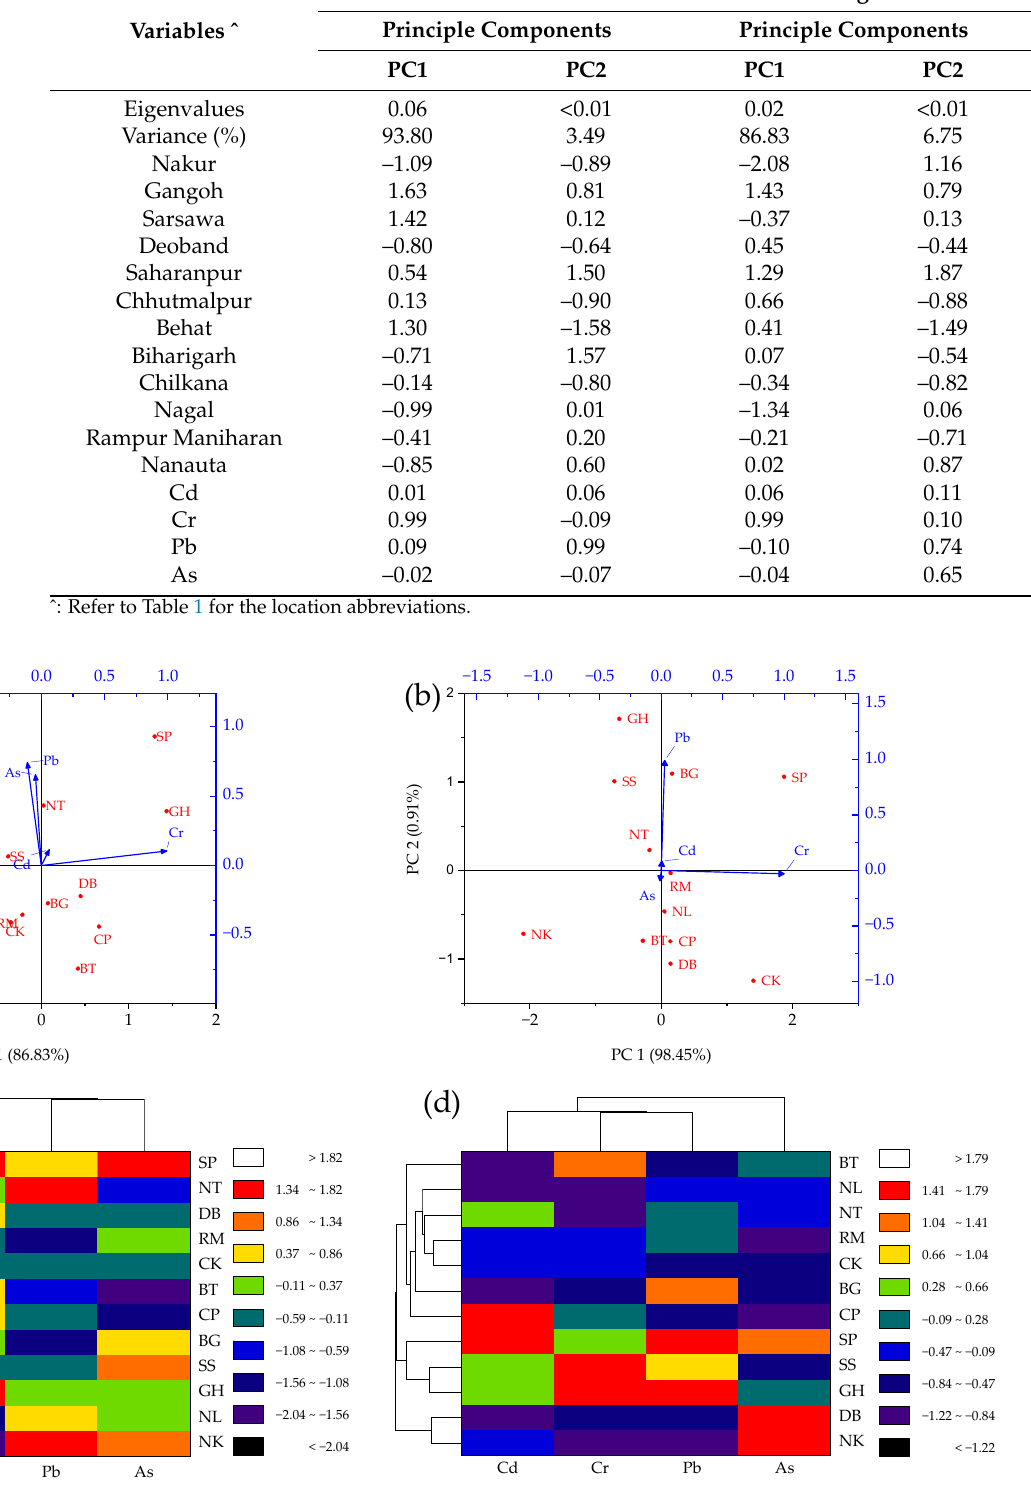
Figure 3. PCA and HCA plots for heavy metals in Dasheri ( a , c ) and Langra ( b , d ) varieties of mango fruits ( M. indica ) as collected from Saharanpur district, Uttar Pradesh, India (refer to Table 1 for the location abbreviations).